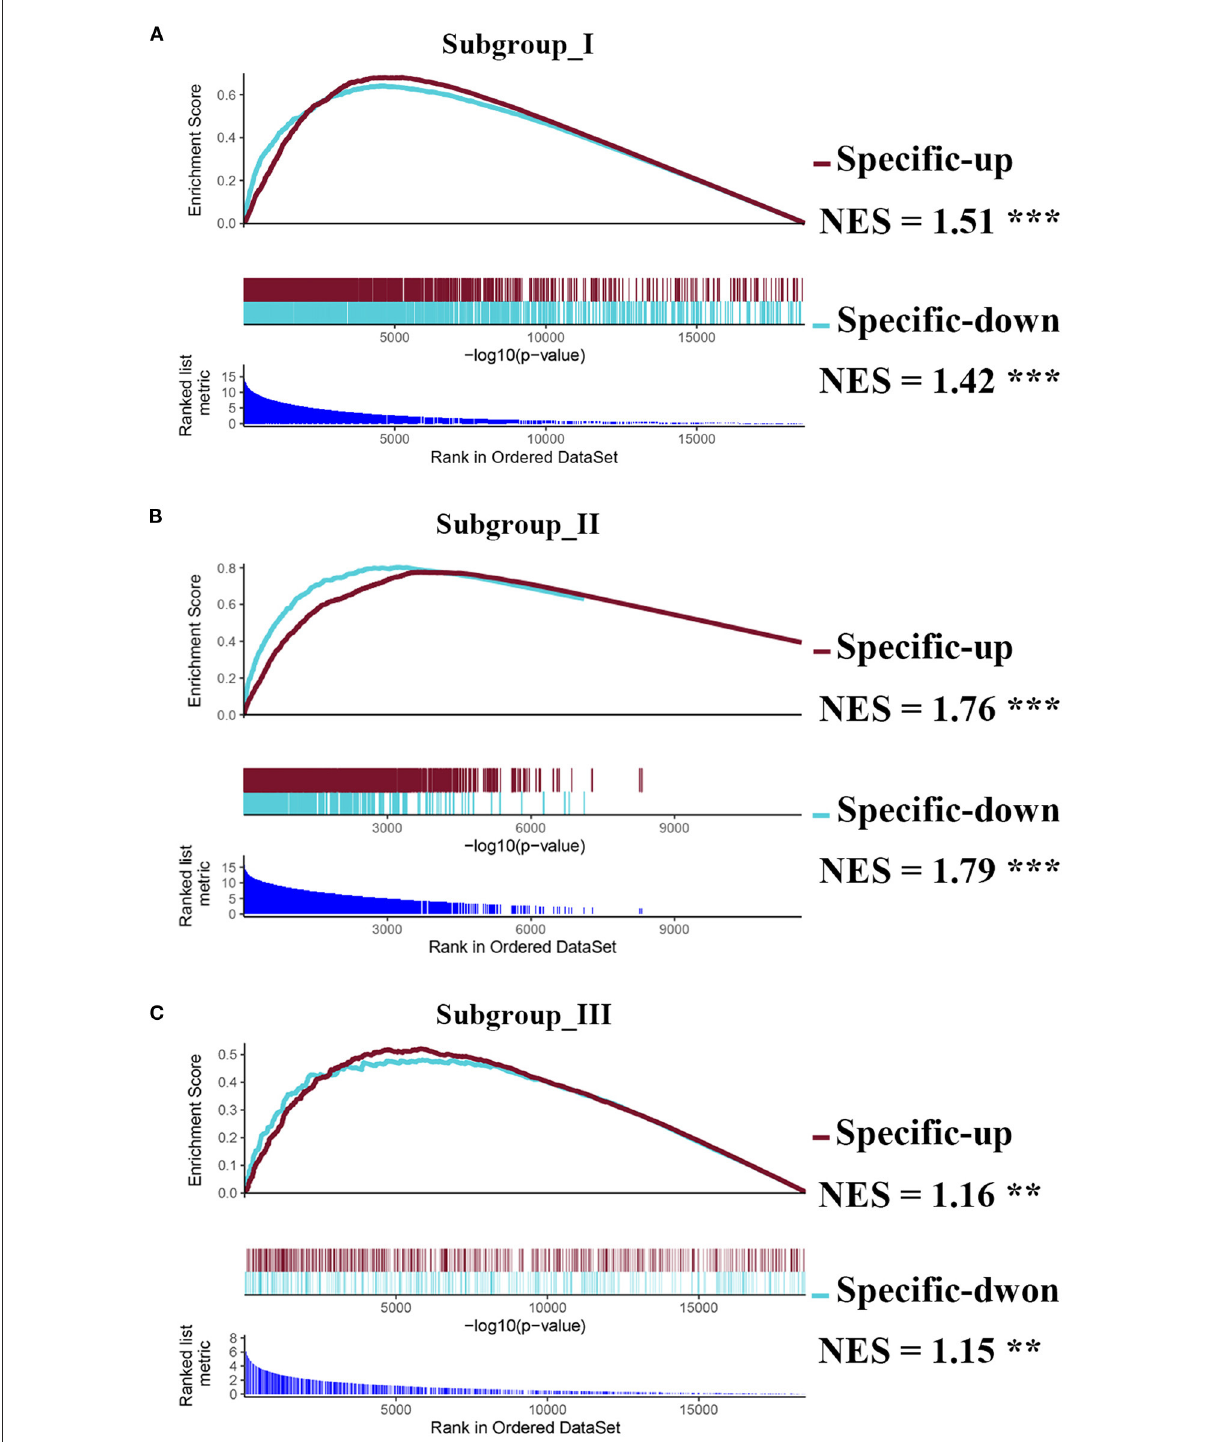
FIGURE2 Identification of subgroup-specific differentially expressed genes and comparison with control. (A–C) GSEA enrichment plots (red lines) showing the subgroup-specific upregulated gene (Specific-up) and subgroup-specific downregulated gene (Specific-down) in subgroup I (A) , subgroup II (B) , and subgroup III (C) . Green lines represent the differentially expressed genes between the corresponding subgroup and the normal controls. NES denotes the normalized enrichment score with FDR ( ** < 0.01, and *** <